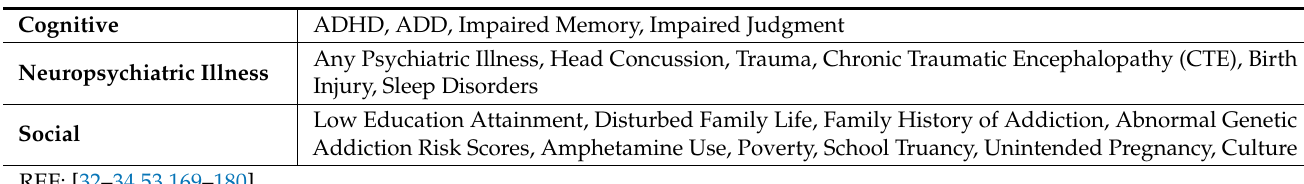
Table 2. SUD premorbid